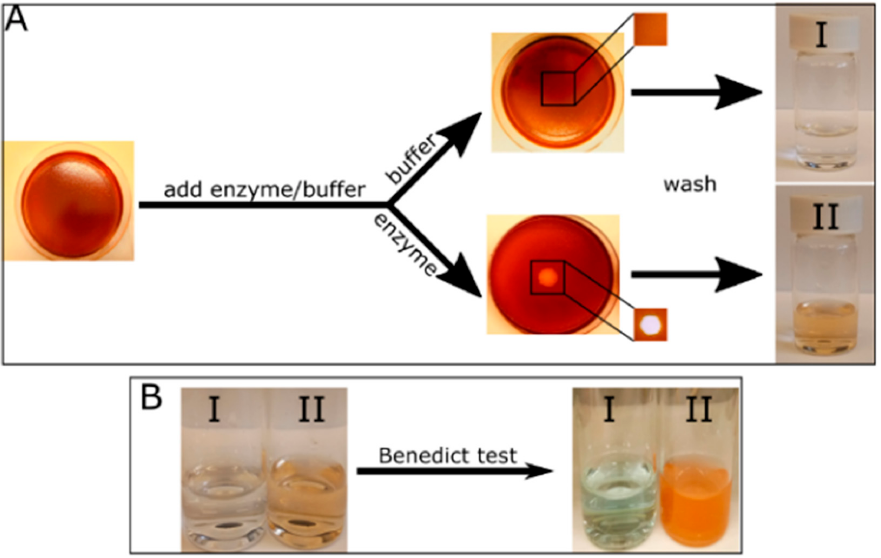
Figure 1. Enzymatic hydrolysis of carboxymethyl cellulase (CMC) film tagged with acridine orange. Dyed CMC films, pre-treated with acetate buffer, were subjected to either 10 μ L acetate buffer (I) or 10 μ L containing 10 μ g cellulase (II). The films were incubated at 37 °C for 2 h, after which a clear halo was formed only on the film subjected to the enzyme ( A , middle section, with enlargement of relevant area). Then, the films were washed with 20 mL of distilled water, which was collected into a vial. Only the water collected from the film subjected to the enzyme showed a change in color ( A , right side). Then, the washed water was subjected to Benedict ′ s test, clearly showing the presence of sugars only in the washed water from the film subjected to the enzyme ( B ).